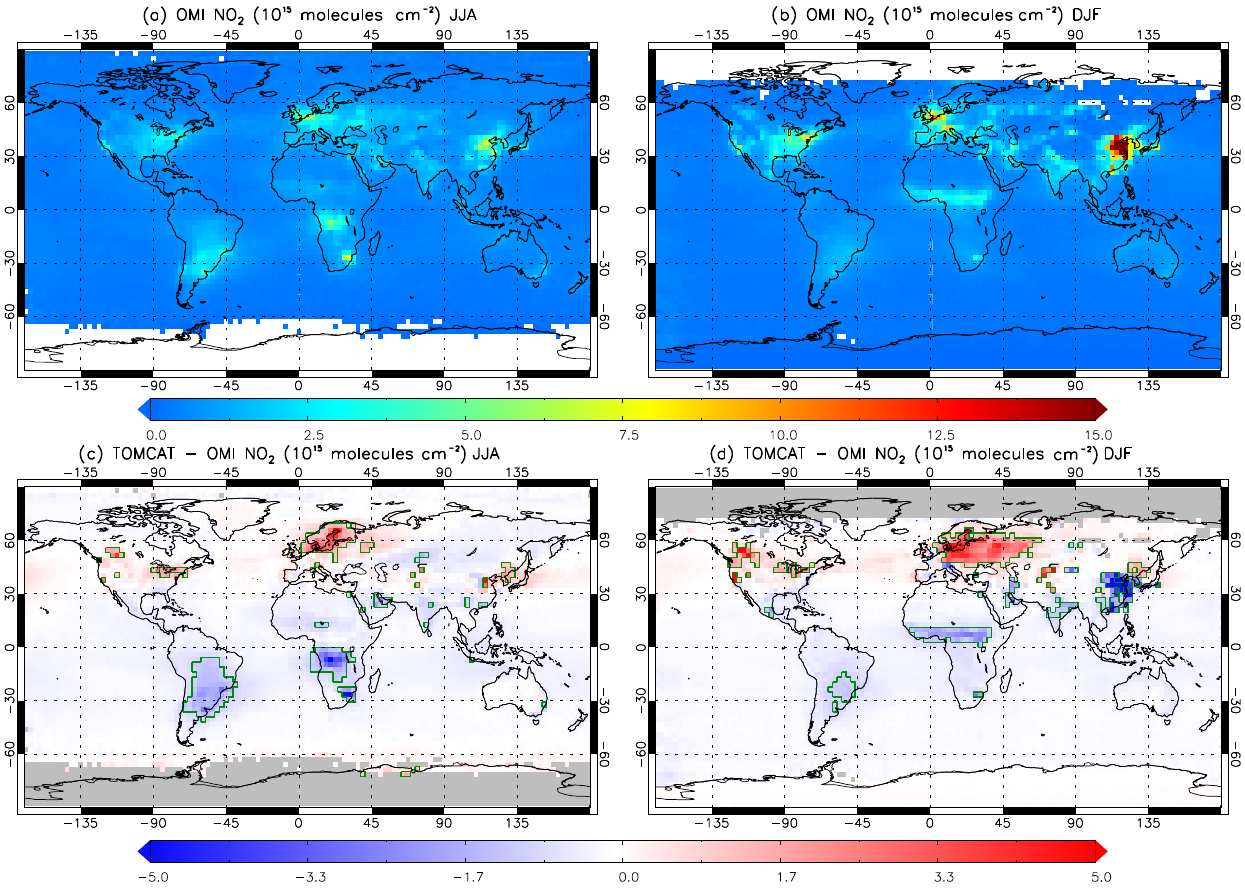
Figure 14. 2008 tropospheric NO 2 column ( × 10 15 moleculescm − 2 ) from OMI on the TOMCAT model 2 . 8 ◦ × 2 . 8 ◦ grid for (a) June– July–August and (b) December–January–February, along with the TOMCAT OMI tropospheric column NO 2 mean bias (MB) for the same periods (c, d) . The green polygons are where the absolute MB is greater than the satellite